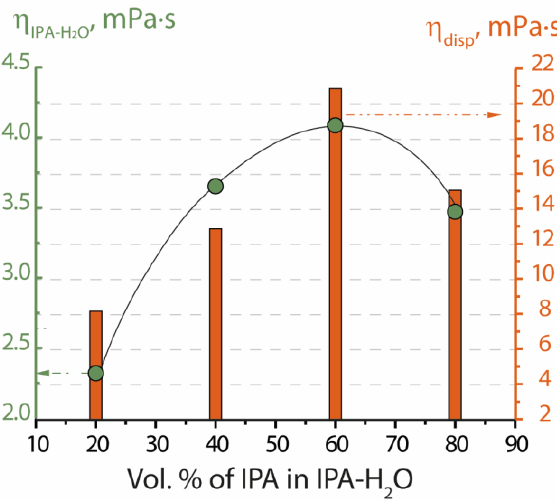
Figure 1. Dependences of solvent viscosity (dots) and viscosity of 5 wt.% Nafion dispersions in Li + - form (columns) on the IPA volume fraction in the mixture IPA-H 2 O. Li + -form (columns) on the IPA volume fraction in the mixture IPA-H